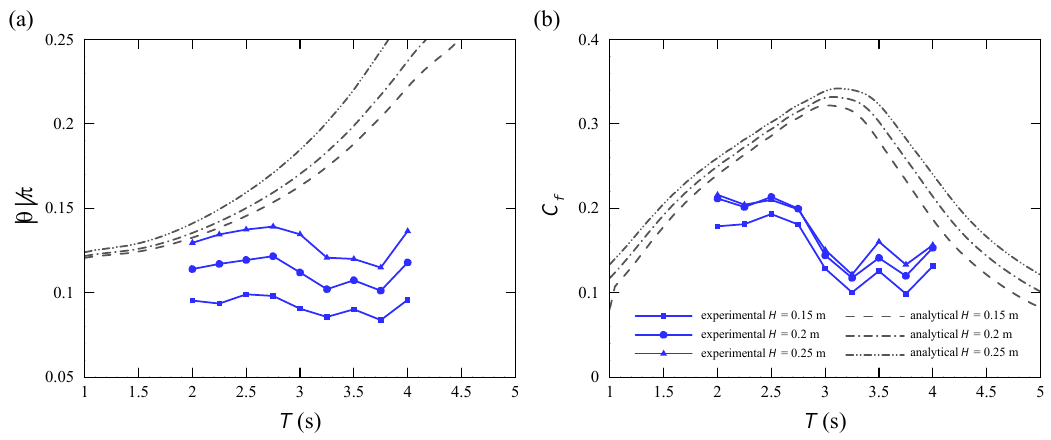
Figure 9. Comparison between experimental and analytical variation of ( a ) amplitude of rotation angle of the flap and ( b ) power capture factor with the wave